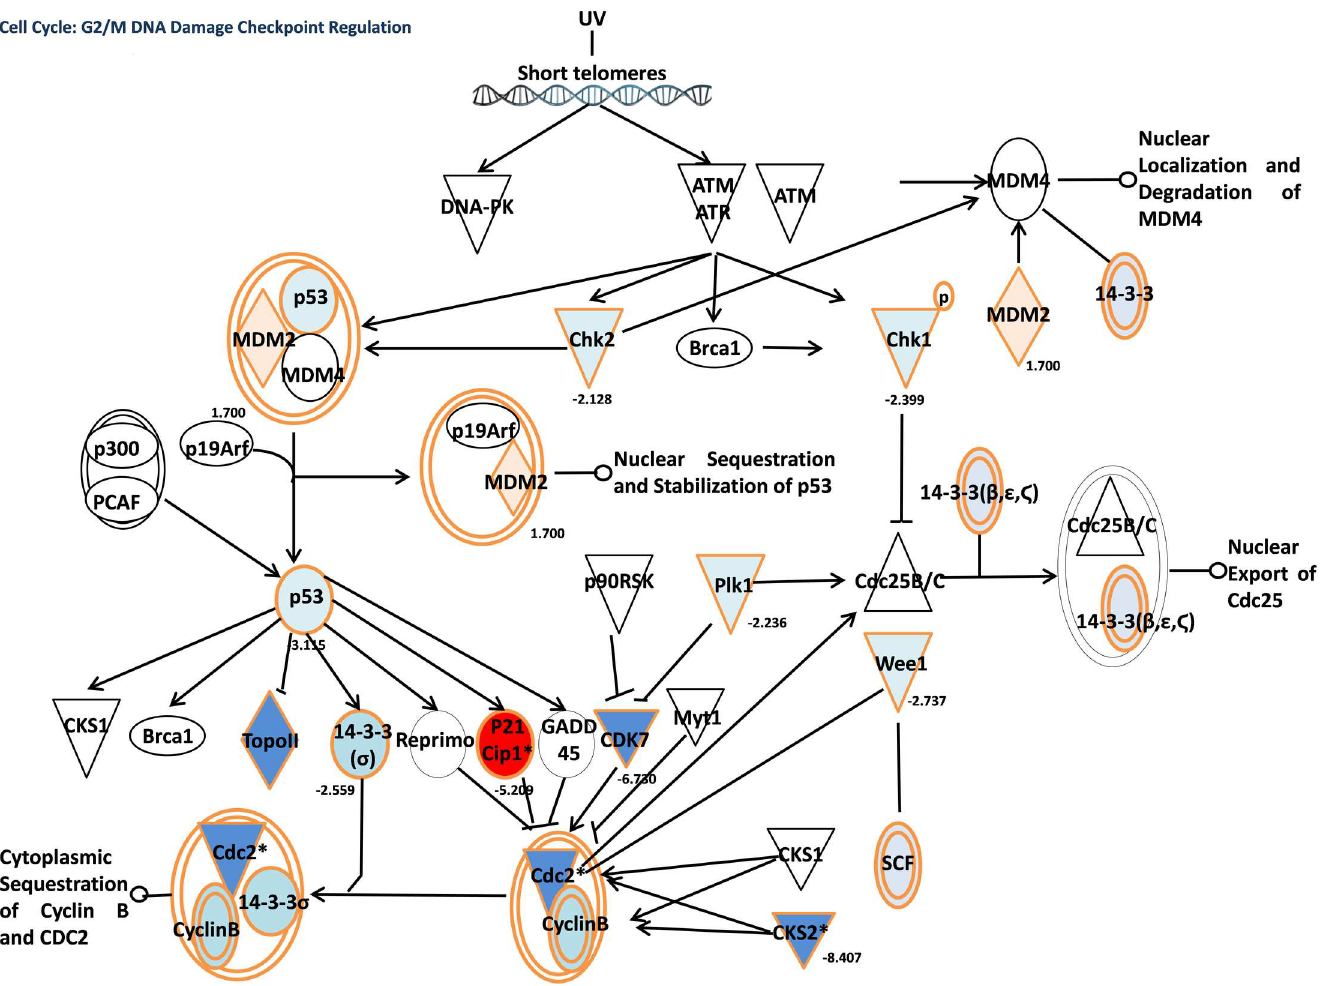
Fig 5. Cell cycle: G2/M DNA damage checkpoint regulation after treating HepG-2 cells with fisetin.